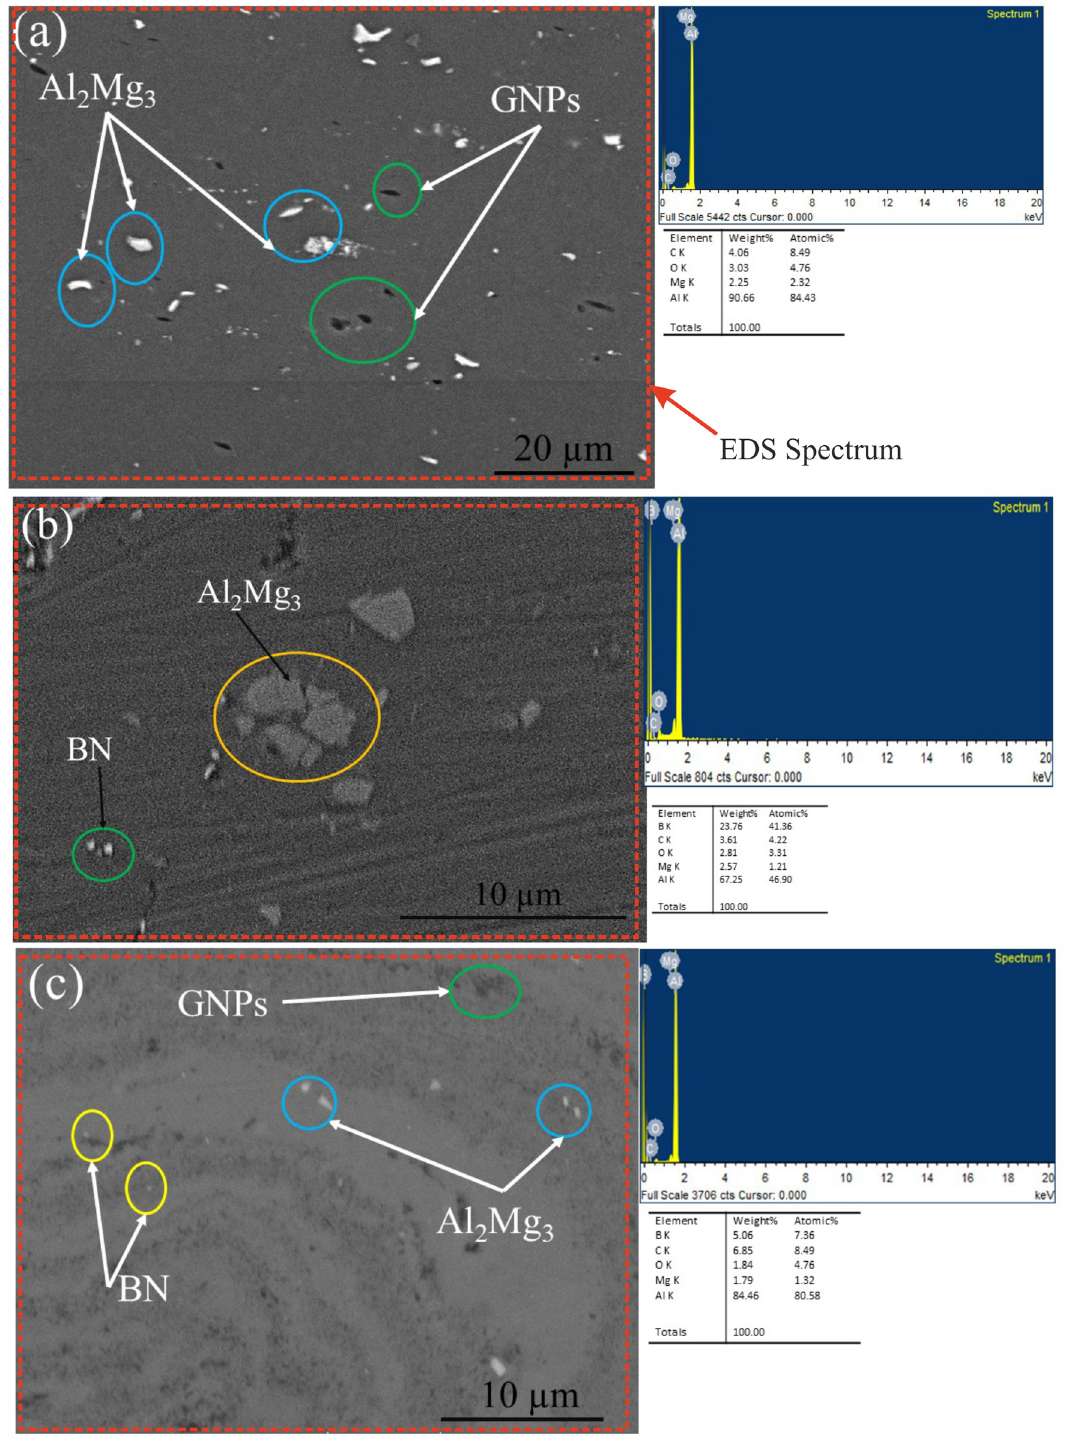
Figure 6: SEM image of the fabricated nanocomposites: ( a ) Al 5251_GNPs, ( b ) Al 5251_BN, and ( c ) Al 5251_BN +